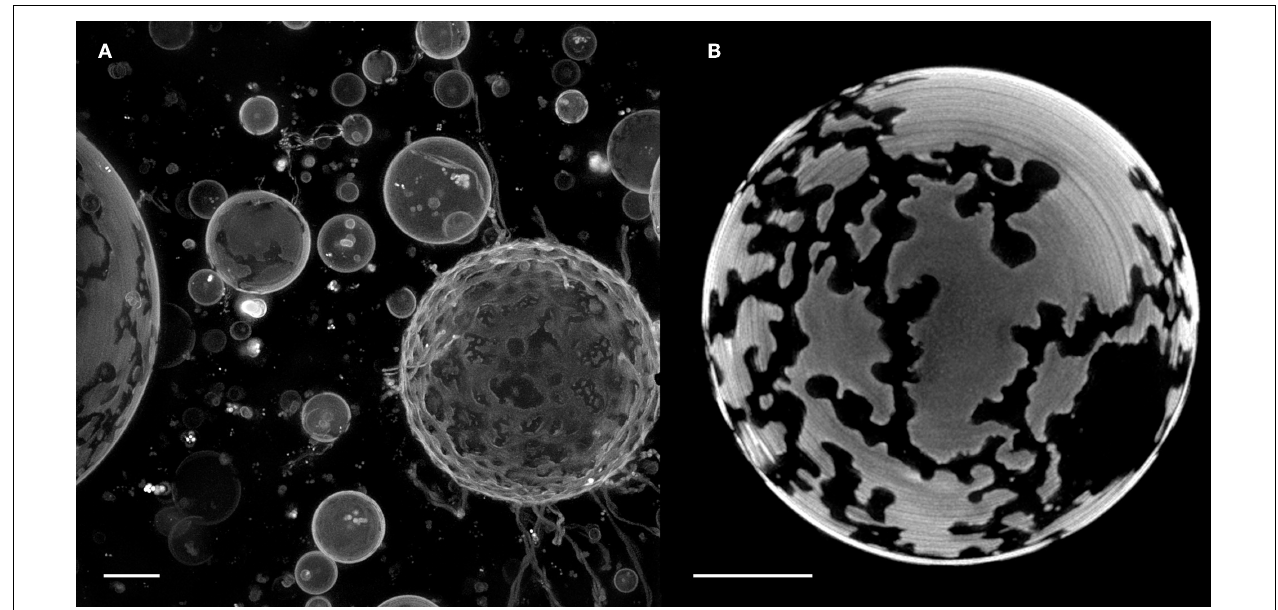
0.5% of the lipid analog 5-TAMRA-J116S.The image shows a deconvolved Z -stack of the whole vesicles. (B) An inflated DOPC:DPPC:GM1 (1:1:1) GUV, entrapping 1M sucrose, after swelling by addition of MilliQ water.The L d phase was stained with 0.5% Rho-DPPE. (Adobe Photoshop was used for the cosmetic removal of out-of-plane artifacts that would have obstructed the view of the details of interest). Image shows a deconvolved Z -stack of the bottom hemisphere. Scale bars: 10 μ